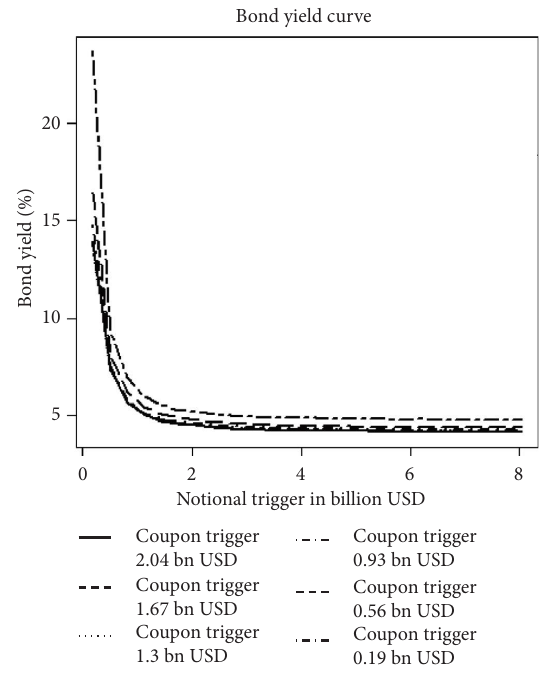
Figure 18: Cyber bond yield